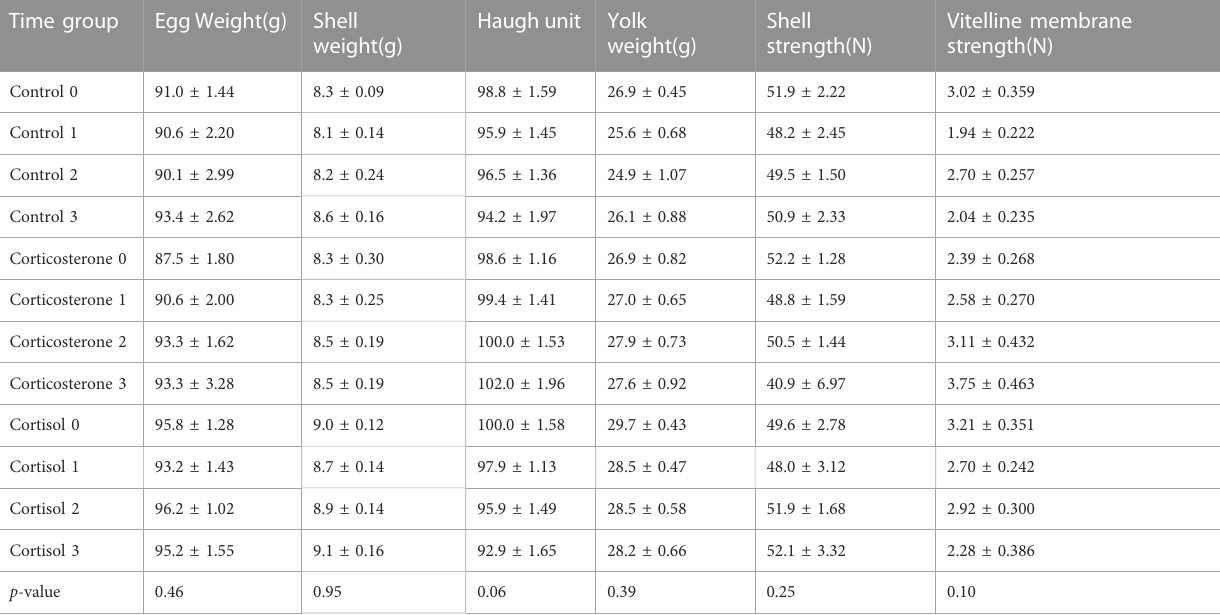
TABLE 2 Effect of a 2-week chronic stress stimulation on egg quality parameters in breeder